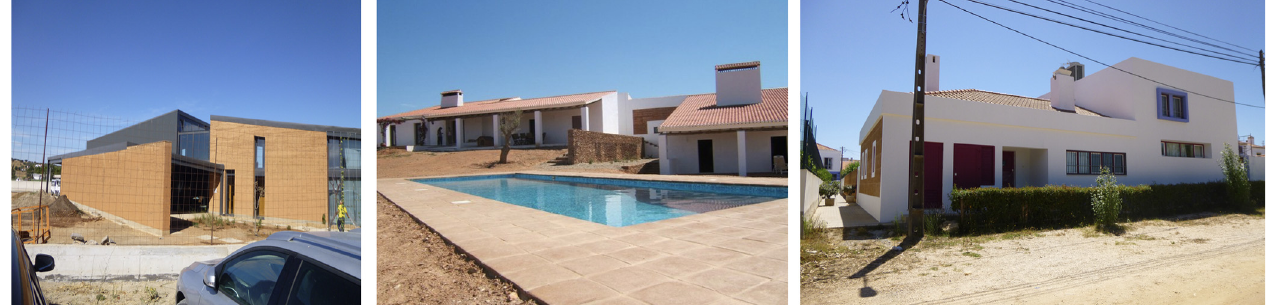
Fig. 4. General images from the three-case study. (a) The architectural of fi ce “ Betão e Taipa ” , (b) The rural hotel “ Cantar dos Grilos ” , (c) The Odemira